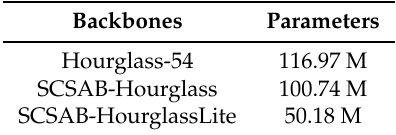
Table 1. The parameters of different backbone networks.